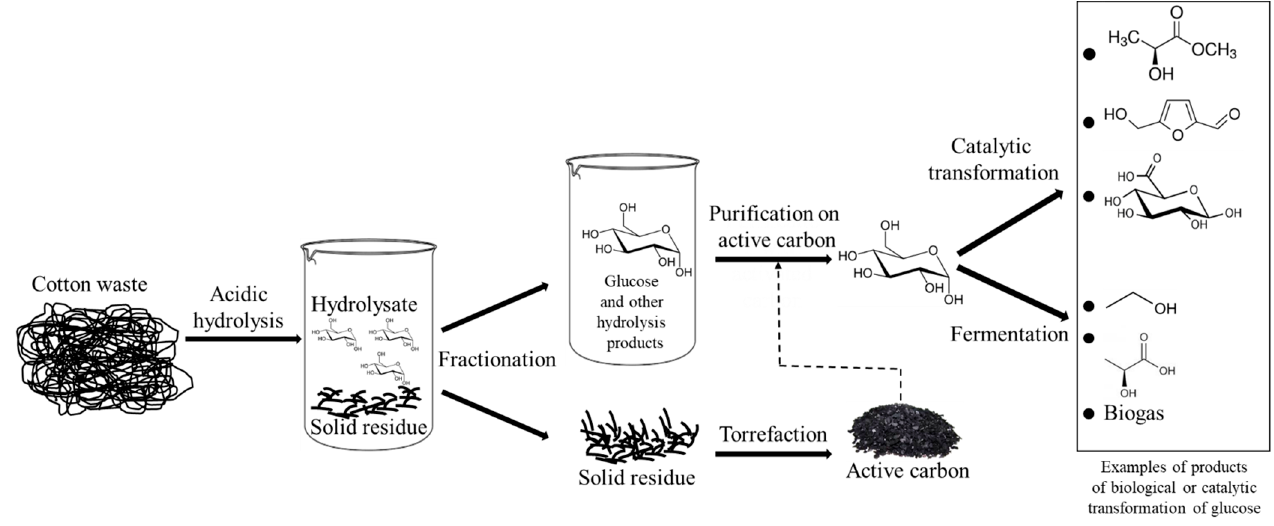
Figure 1. Scheme of cotton waste management, including acid hydrolysis and further chemical and biological processes to convert glucose into useful chemical products.